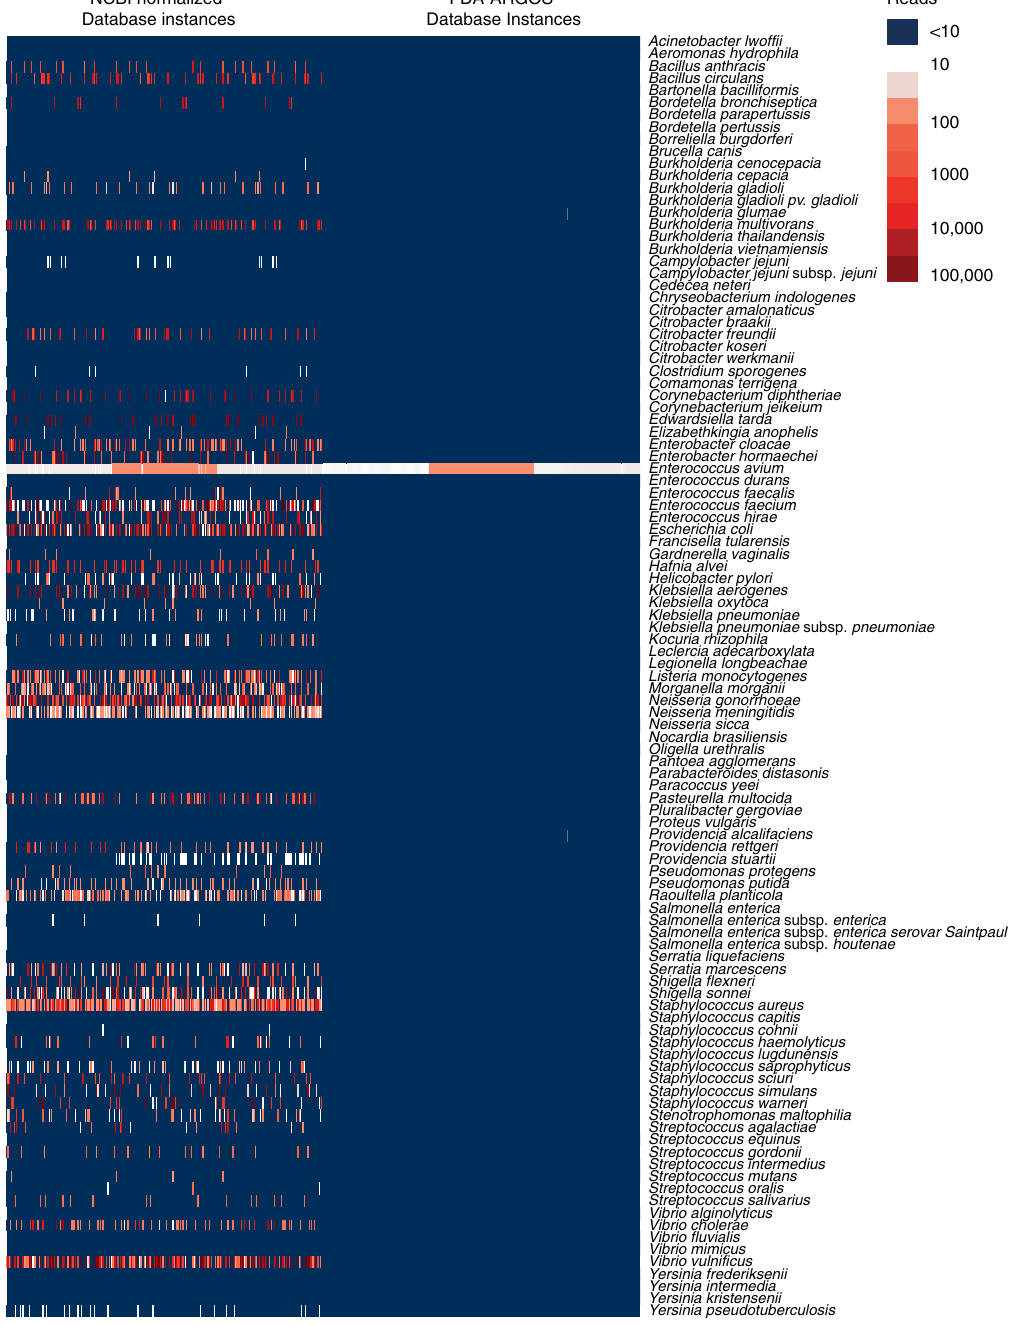
FDA-ARGOS (Fig. 4), NCBI Nt mapped reads to over 30 different species other than the pathogen in this sample, E. avium . The highest number of reads, 34,879 reads on average, matched Vibrio vulni fi cus compared with 62 reads on average for E. avium .